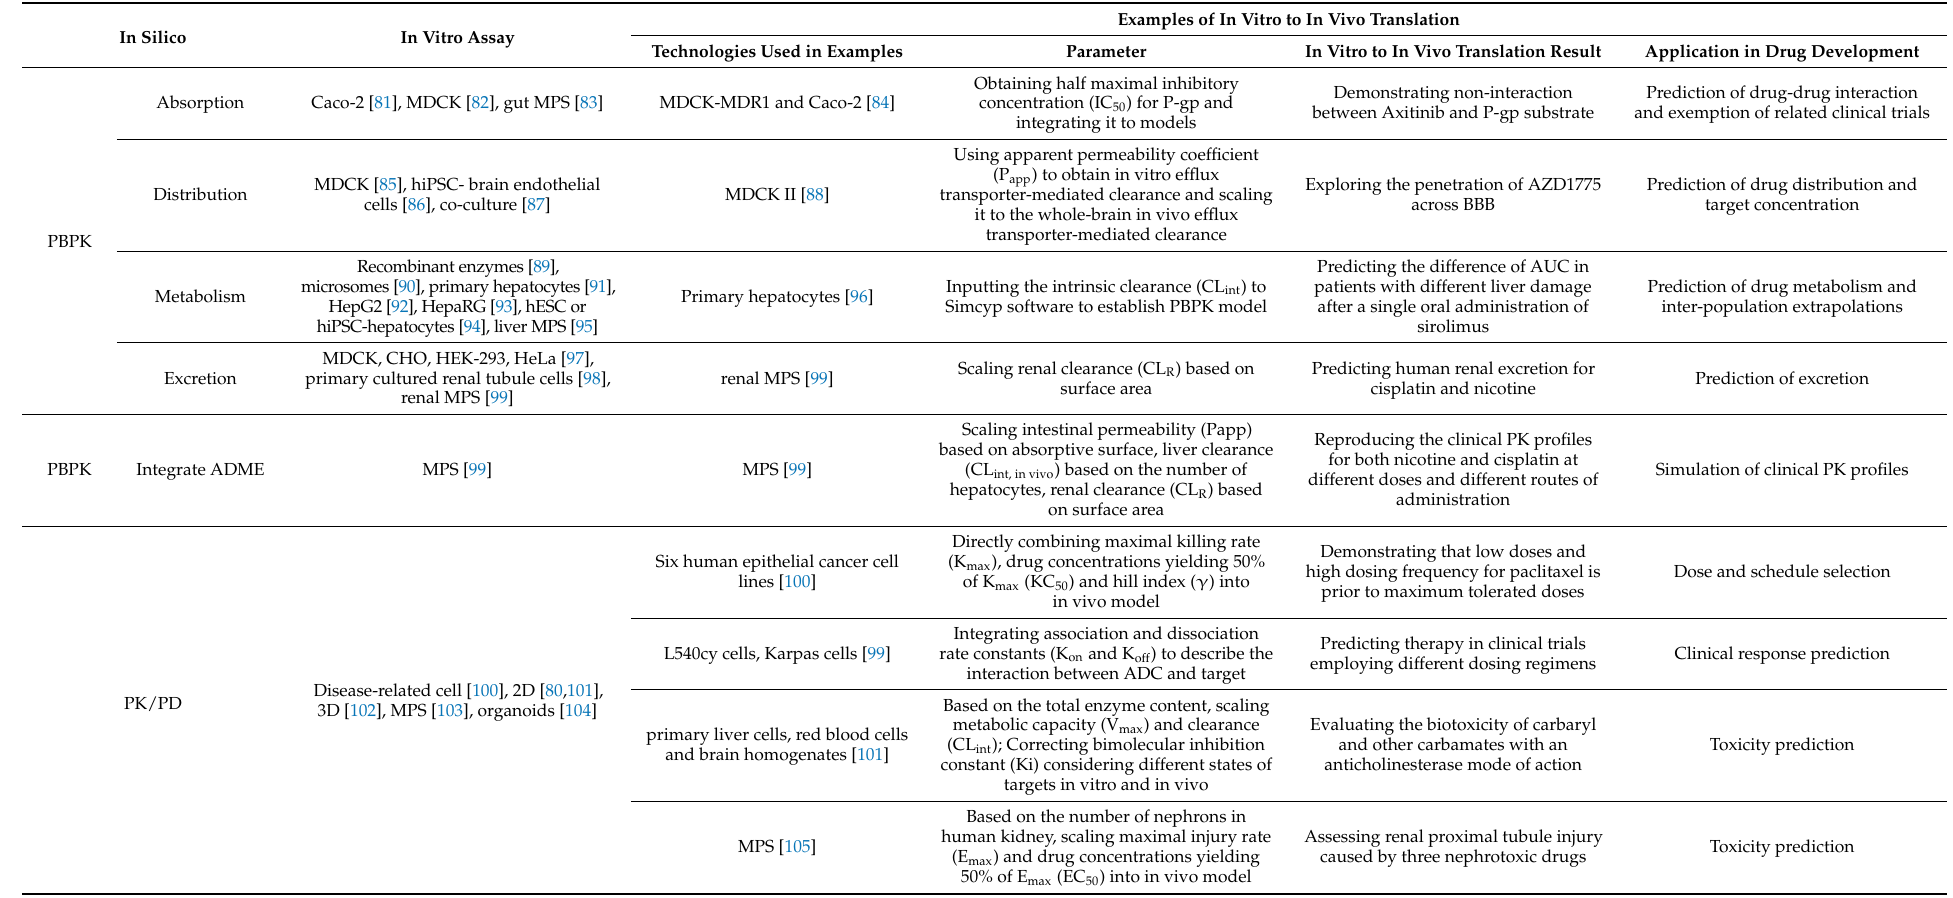
Table 1. In Vitro to In Vivo translational